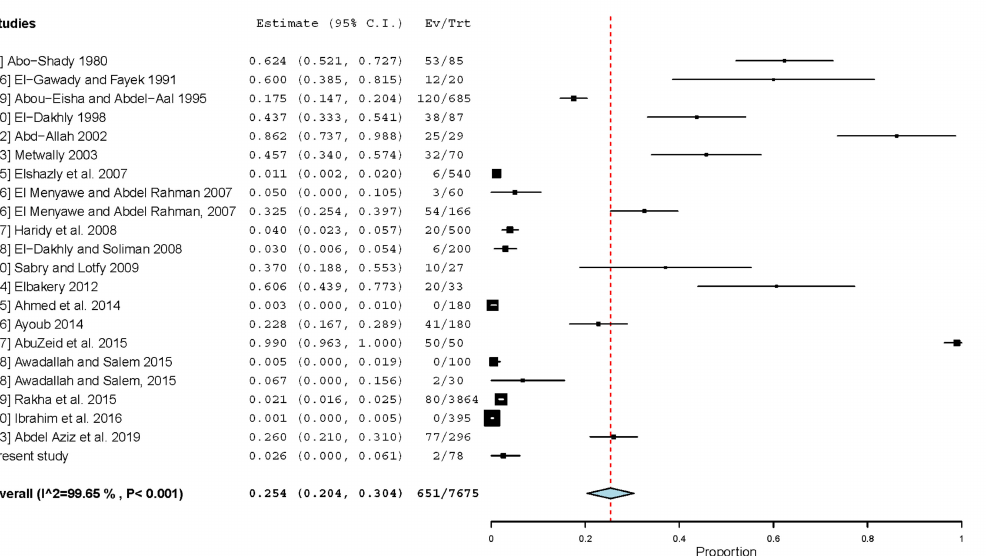
Figure 4. Forest plot diagram for random effects in the meta-analysis of the prevalence of D. caninum in dogs from Egypt. The length of the line indicates 95% confidence interval of each study and the middle point of each line refers to the prevalence. Diamond refers to the overall